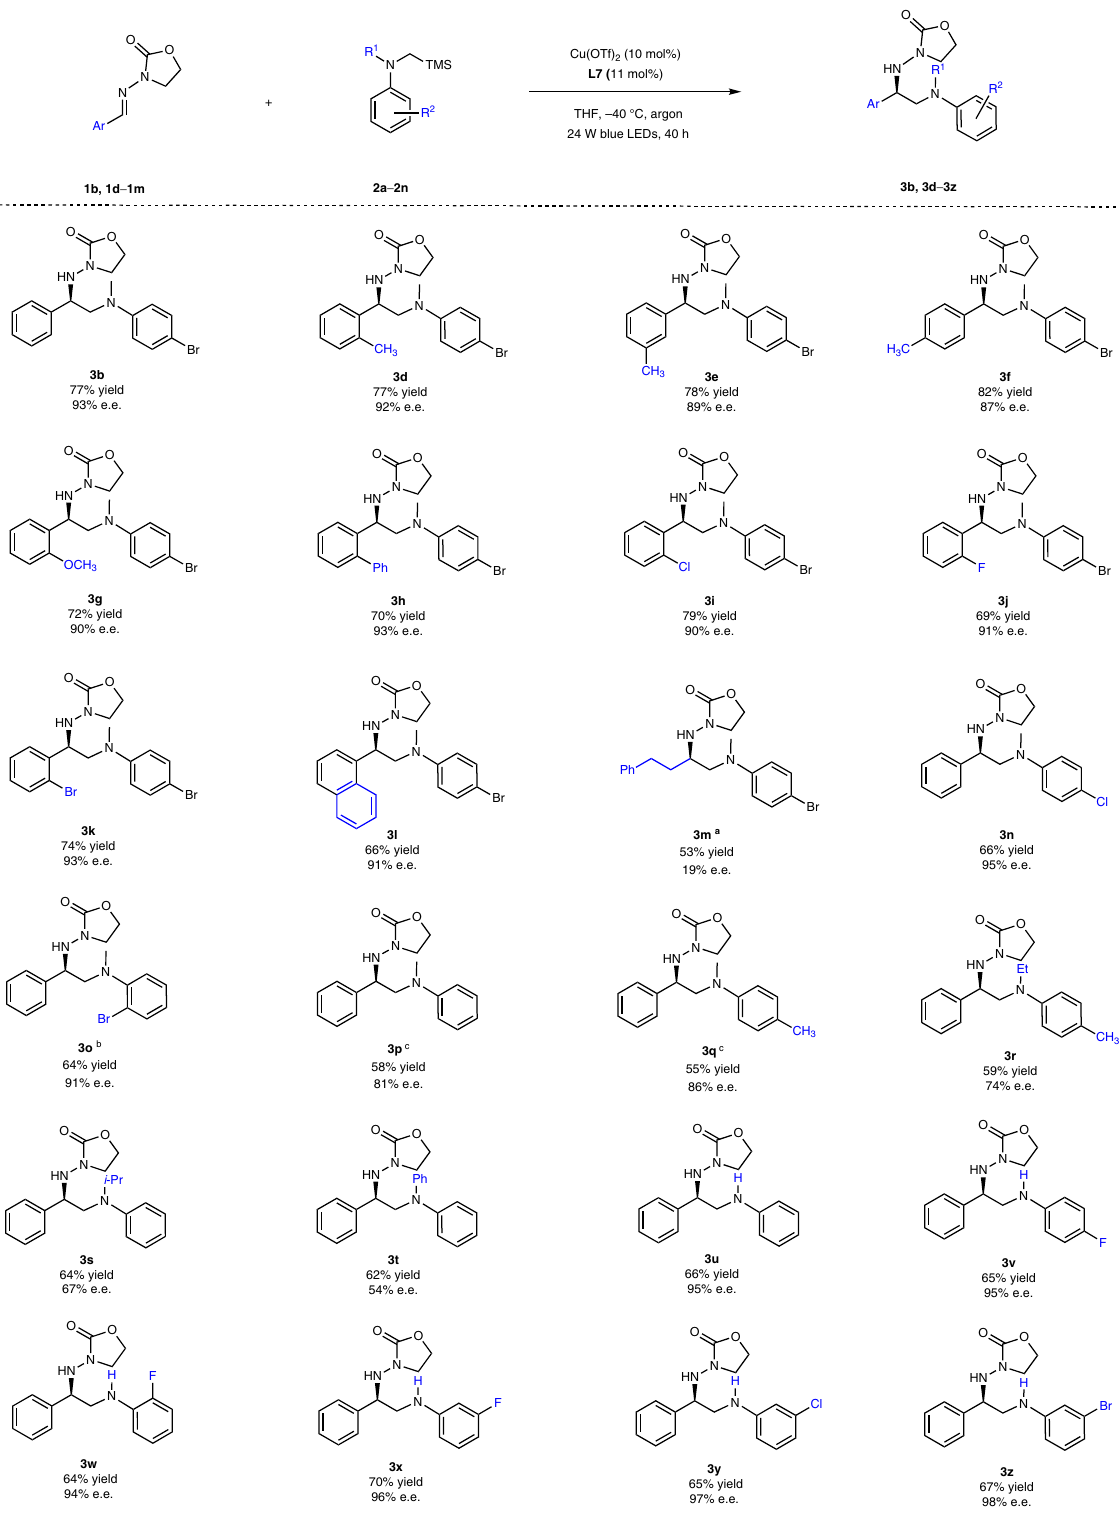
Fig. 3 Reaction scope. a Reaction performed at 25 °C. b Reaction performed with 20 mol% Cu(OTf) 2 and 22 mol% ligand L8 . c Reaction performed with 20 mol% Cu(OTf) 2 and 22 mol% ligand was obtained in 73% yield and with signi fi cantly lower enan- tioselectivity of 19% at a higher temperature of 25 °C within 40 h.